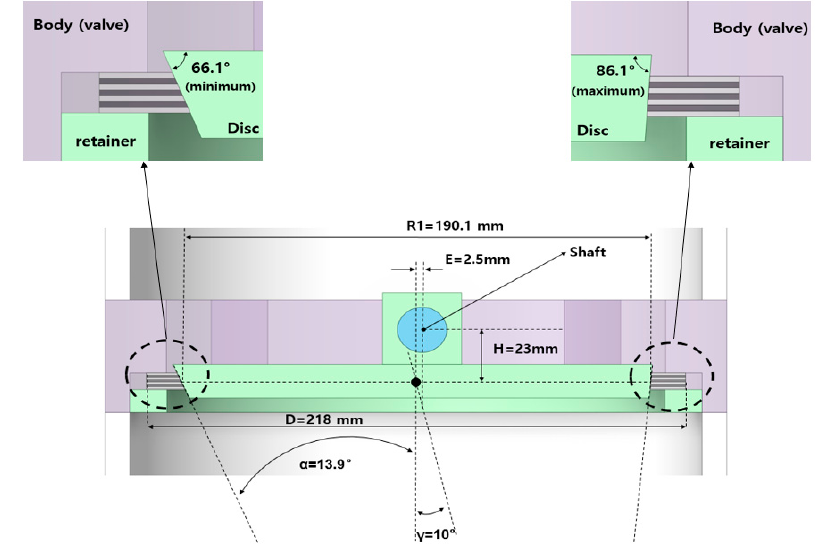
Figure 10. 2D geometry of the QOBV. Table 2. Material properties of QOBV.